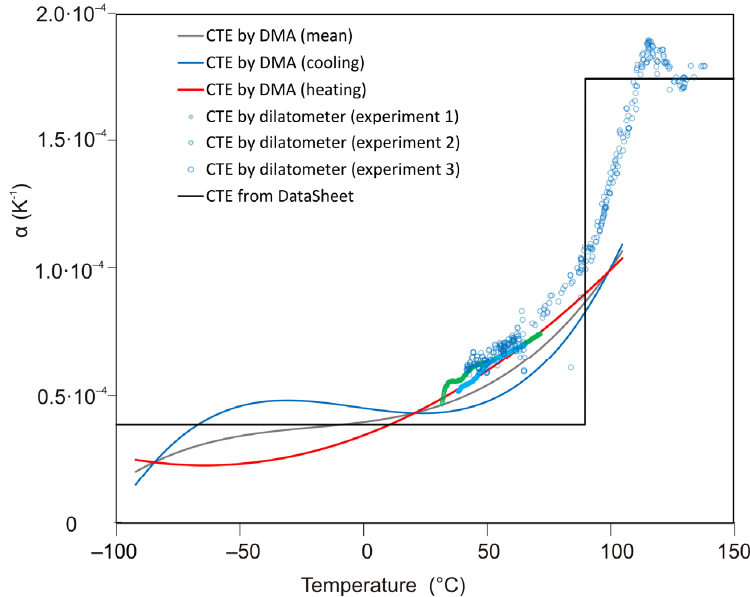
Figure 15. Dependence of the thermal expansion coefficient α (T) for EPO-TEK 330 polymer, measured by DMA, dilatometer and from manufacturer datasheet. Cooling/heating rates are 2 °C/min (except experiment 3, where the cooling rate is 1 °C/min).